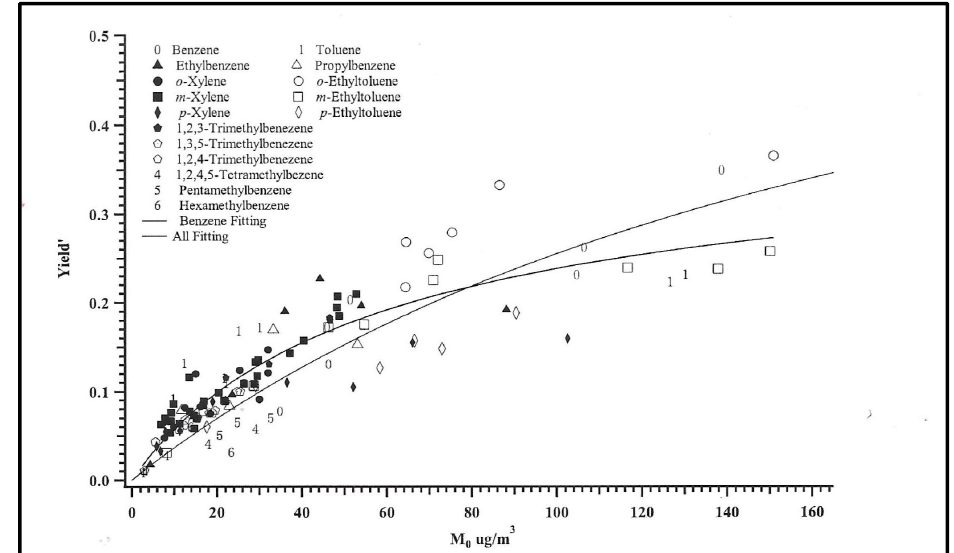
Figure 7. Yield curves for C 6 -C 9 aromatic compounds from smog chamber experiments compared with VOC yield fitting. Yield is proportional to a mass-based stoichiometric coefficient and a partitioning coefficient. The shallower fitted yield curve at low M o is that for benzene [193].